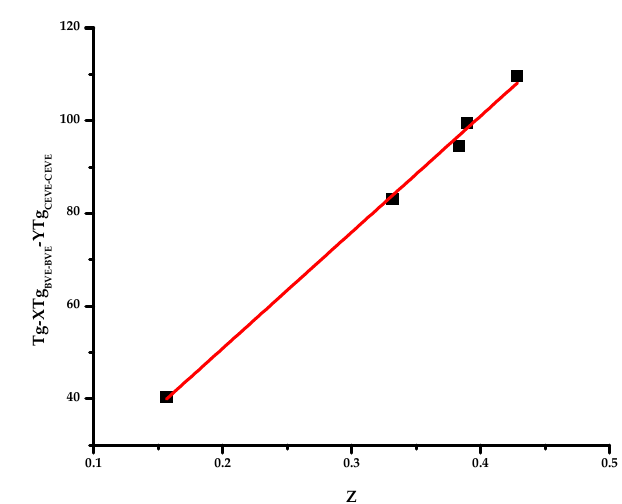
Figure 4. Barton plot for the statistical copolymers.